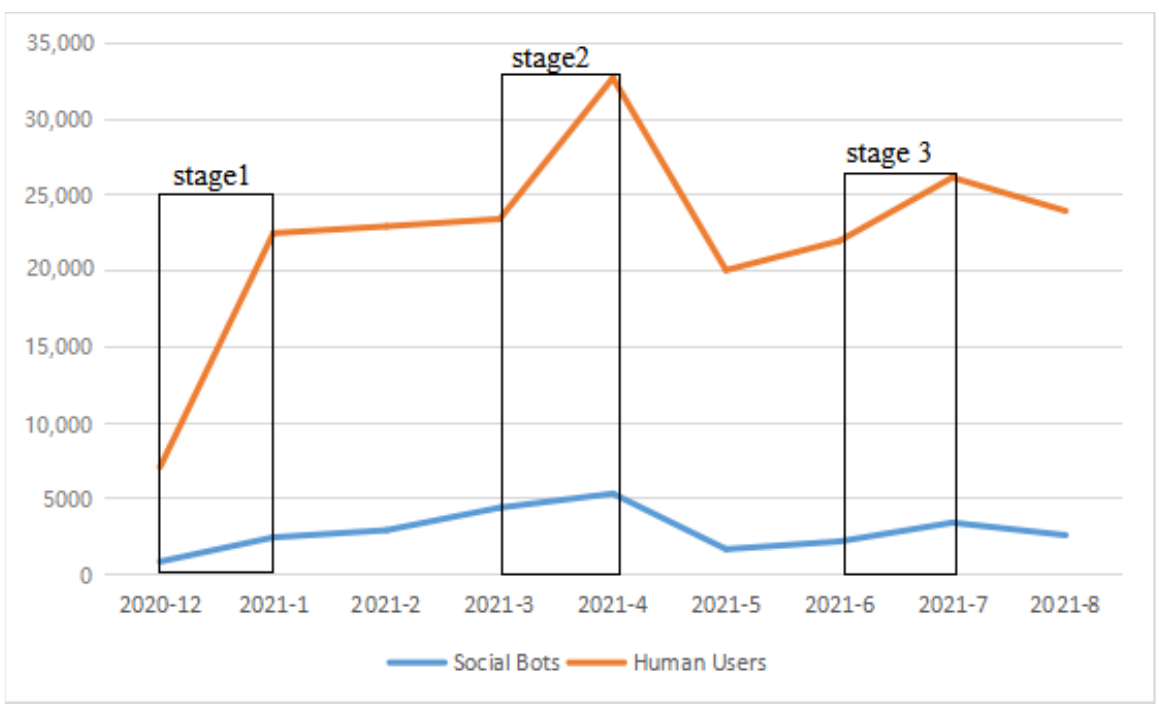
Figure 2. Number of monthly tweets of bots and Humans from December 2020 to August 2021.